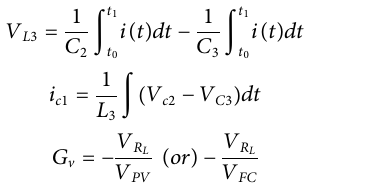
State 2: The auxiliary switch A 2 is closed to become connected with the fuel cell source, and auxiliary switch A 1 is opened to disconnect the solar PV source, as shown in Figure 4 (state 2). The switch S 2 is turned on, during which time the inductor L 2 is being charged. The inductor is intended to release its stored energy when the main switch S 2 is in the OFF condition and D 1 is in the ON condition. The steady state equations of state 2 are derived as follows.